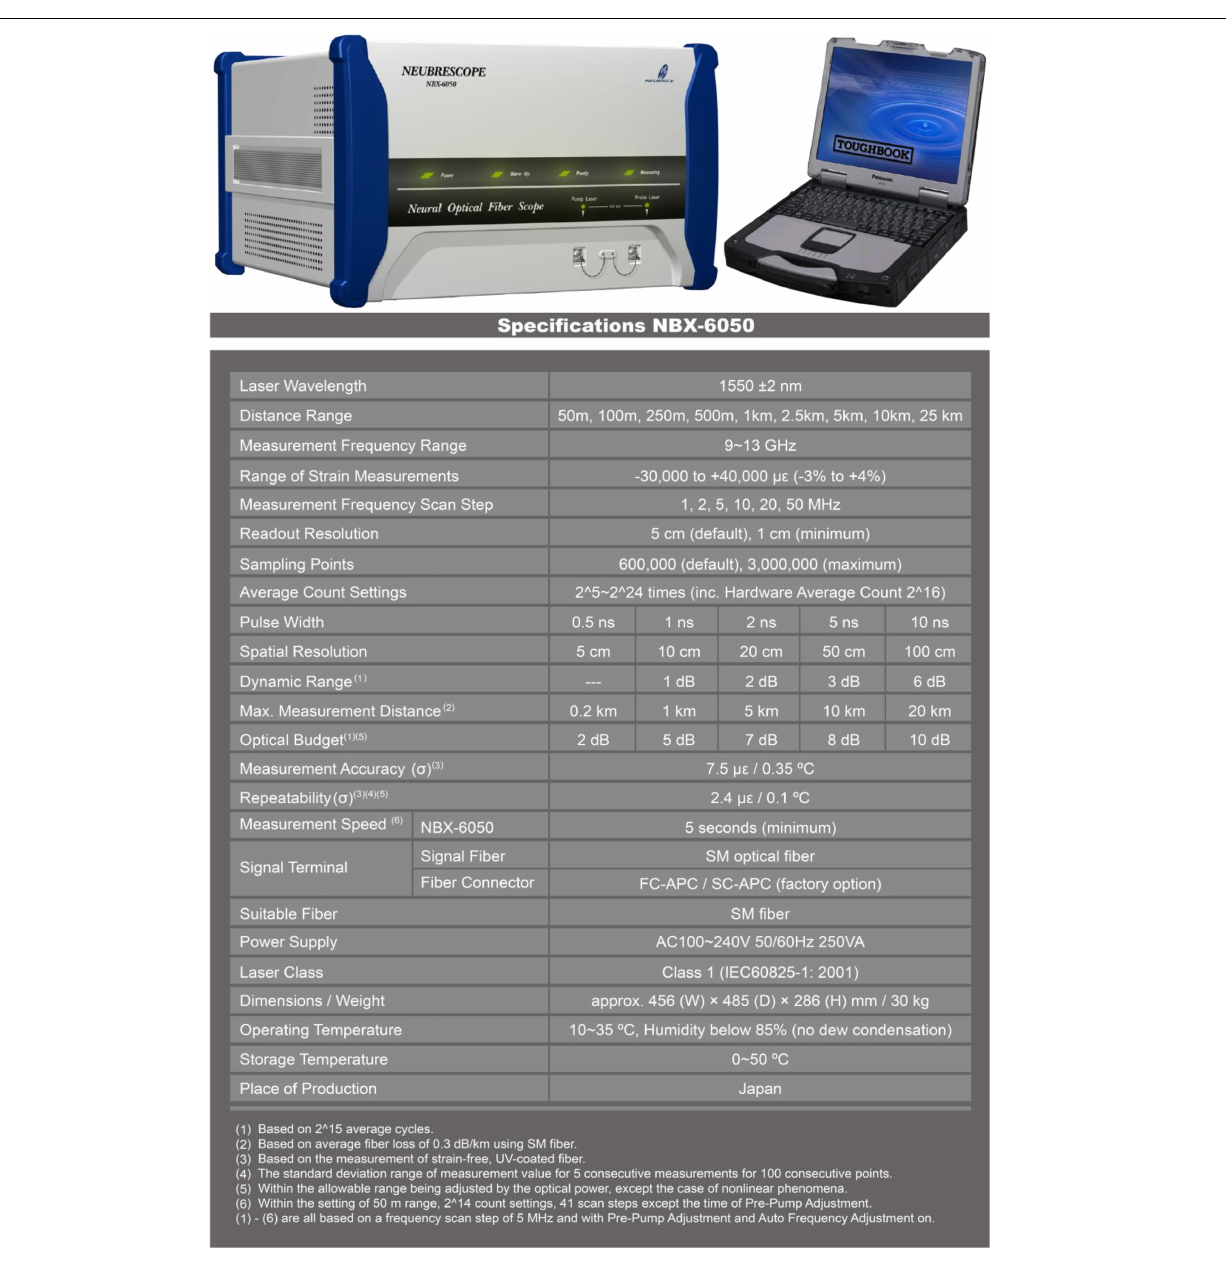
western end traverses the boundary of the landslide warning